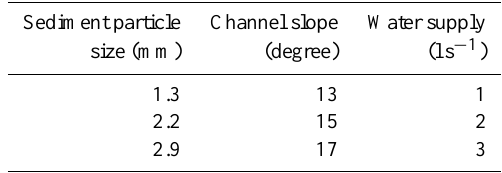
Table 1. Sediment particle sizes, inclination of the open channel, and water flow